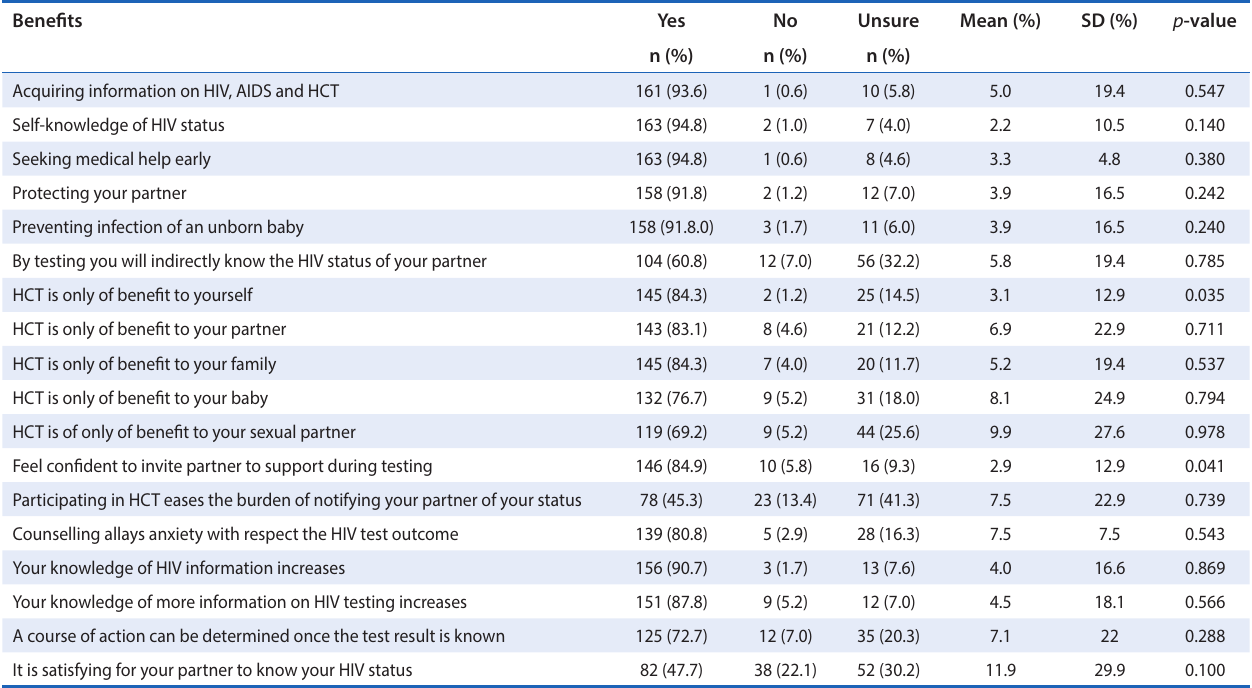
Table 2: Perceptions of the benefits of HIV counselling and testing ( n = 172)